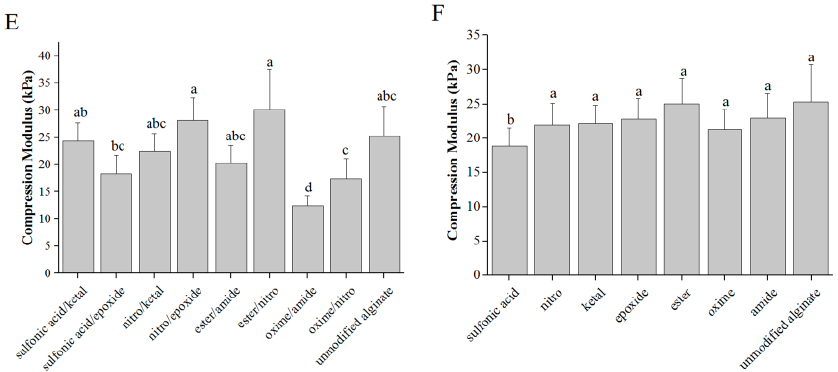
Figure 2. Characterization of combined and single modified alginates: ( A , B ) percent modifications; ( C , D ) WCAs; and ( E , F ) compression moduli were measured for double ( A , C , E ) and single ( B , D , F ) modifications. n = 5. Data represent the mean value ± standard deviation. Bars with the same letter (a–f) are not statistically different ( p < 0.05).